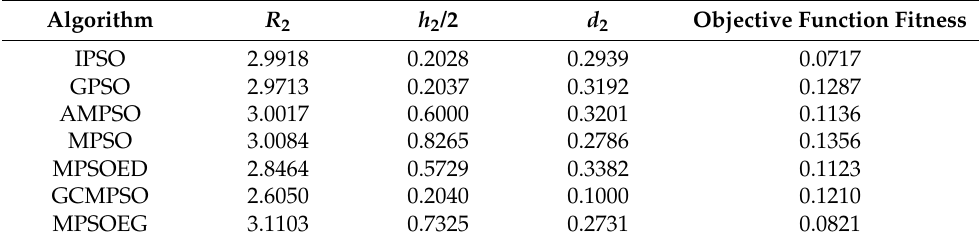
Table 3. Results Comparison of IPSO with other variants on TEAM Workshop Problem